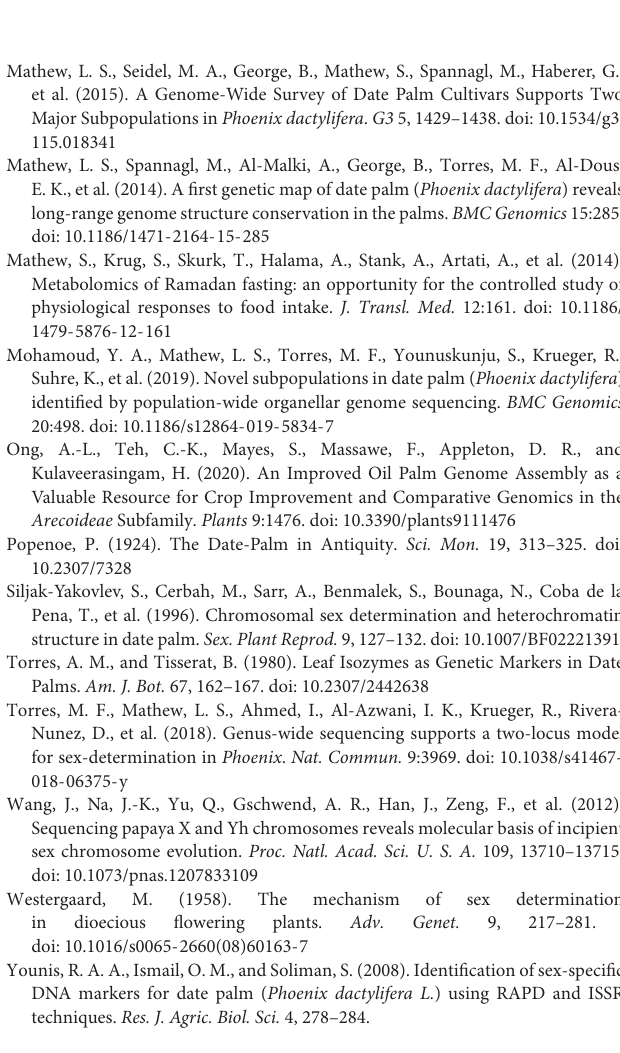
Supplementary Table 1 | An excel file containing information about contigs that passed all filters in this study including which Kmer Density Block they are assigned